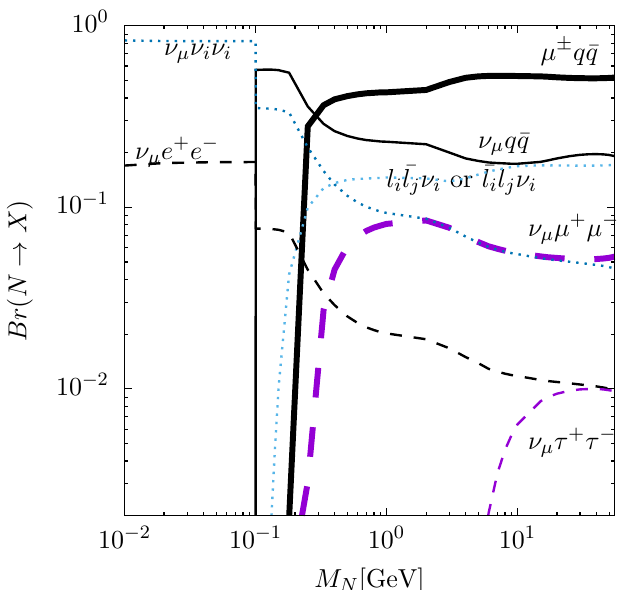
X ) of the RH neutrino N into the denoted channels X ! = j and the heavy neutrino is 6 = 0, V e;(cid:28)N = 0. In this case, the branching 6